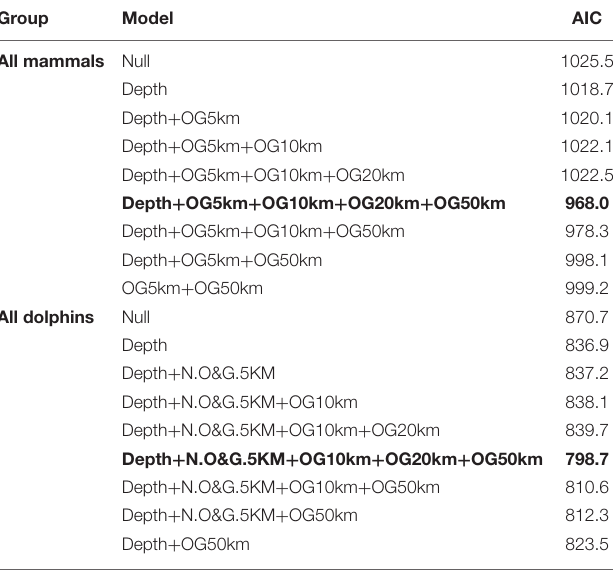
TABLE 3 | Best supported model (in bold) for the relation between all mammals and all dolphins group size and depth and number of oil and gas facilities within 5, 10, 20, and 50 km radius.